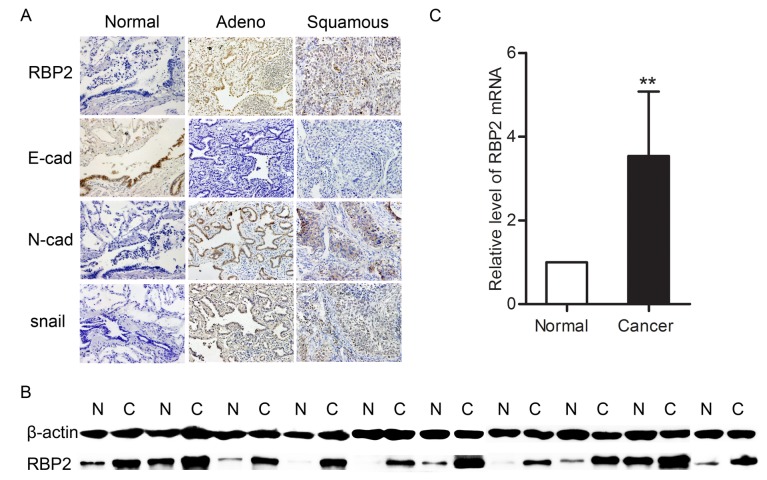
The expression of RBP2, E-cadherin, N-cadherin and snail in normal lung tissues and lung cancer tissues.A. Immunohistochemistrical analysis of RBP2, E-cadherin, N-cadherin and snail (magnification × 200). RBP2, N-cadherin and snail were strongly positive in both adenocarcinoma and squamous carcinoma samples, whereas E-cadherin was weakly stained or unstained. B. Western blot analysis of the RBP2 protein. N = normal lung tissue, C = lung cancer tissue. C. Real-time PCR analysis of RBP2 mRNA. The level of RBP2 mRNA was higher in the lung cancer tissues than in the normal lung tissues (P = 0.0011). *P < 0.05 and **P < 0.01.